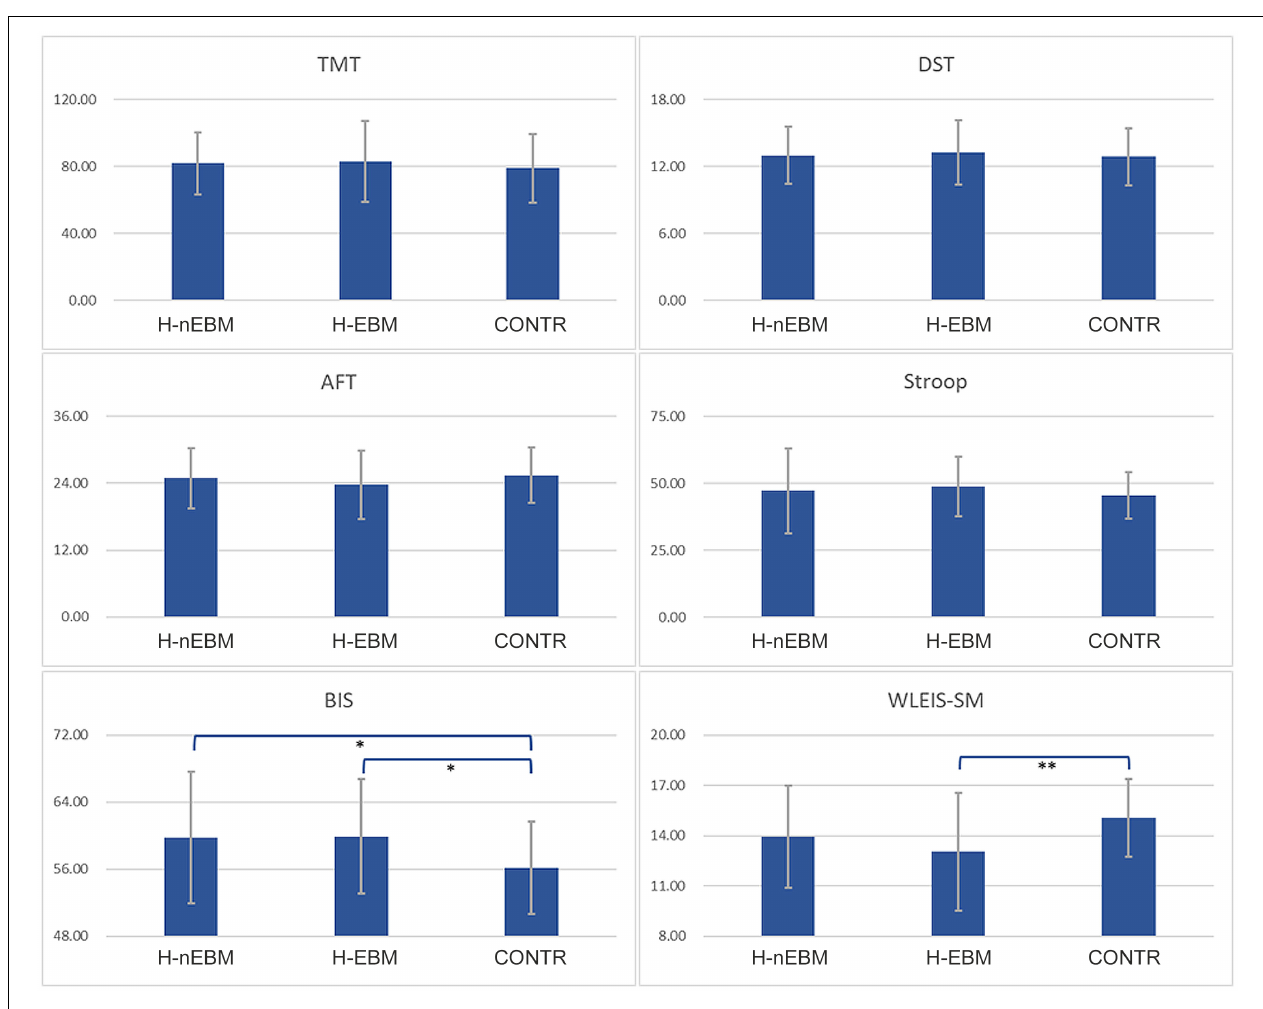
FIGURE 4 | Psychological assessment results of 108 participants. ∗ P < 0.05 and ∗∗ P < 0.001. TABLE 2 | The results of eye-tracking